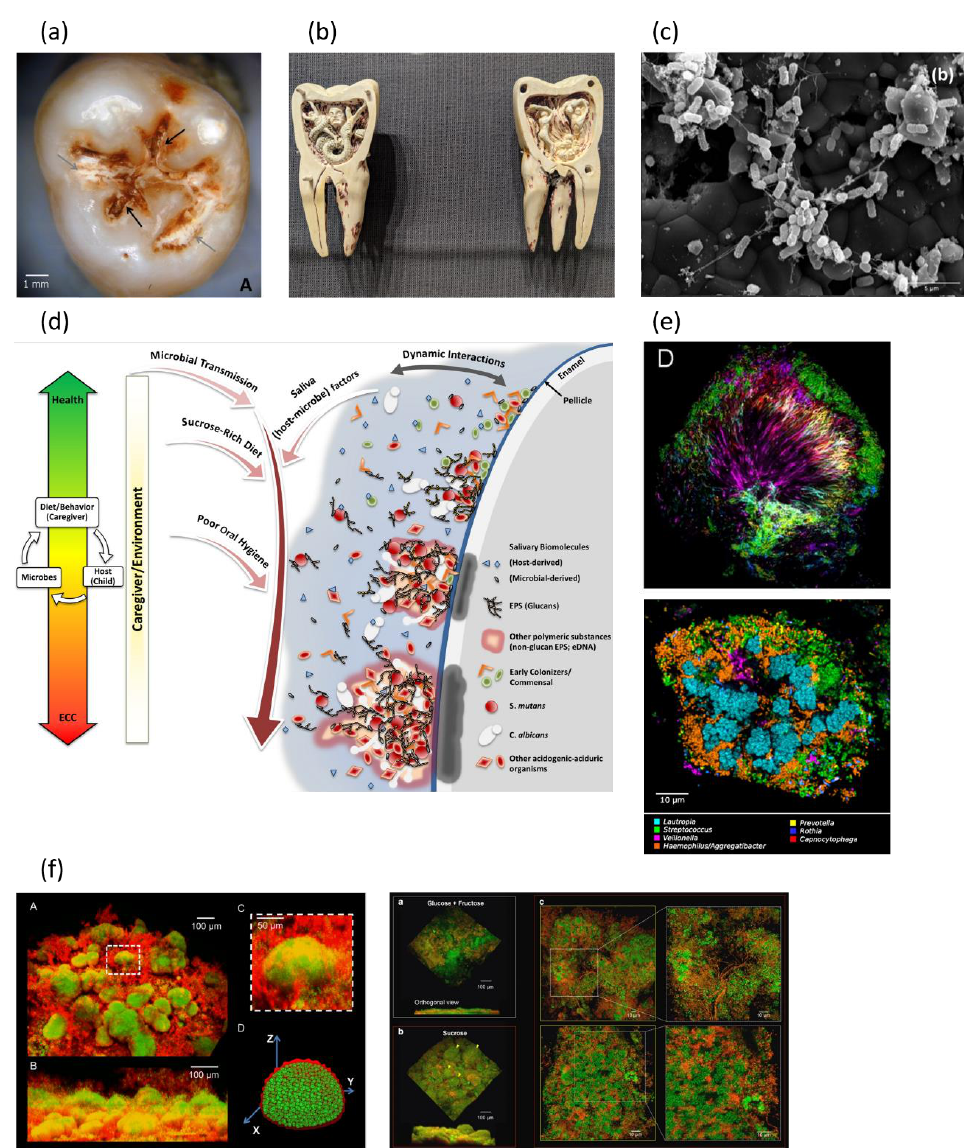
Figure 1. Imaging and illustration of dental caries, Streptococcus mutans and biofilms. ( a ) Photographic image of the surface of a tooth with dental caries showing the visual appearance of dental caries (adapted from [12] with permission. Copyright 2015, John Wiley and Sons). ( b ) Photographic image for the illustration of the dental caries image as a replica toothworm sculpture model of the 18th century original owned by the German Dental Association, image courtesy of the Dr. Samuel